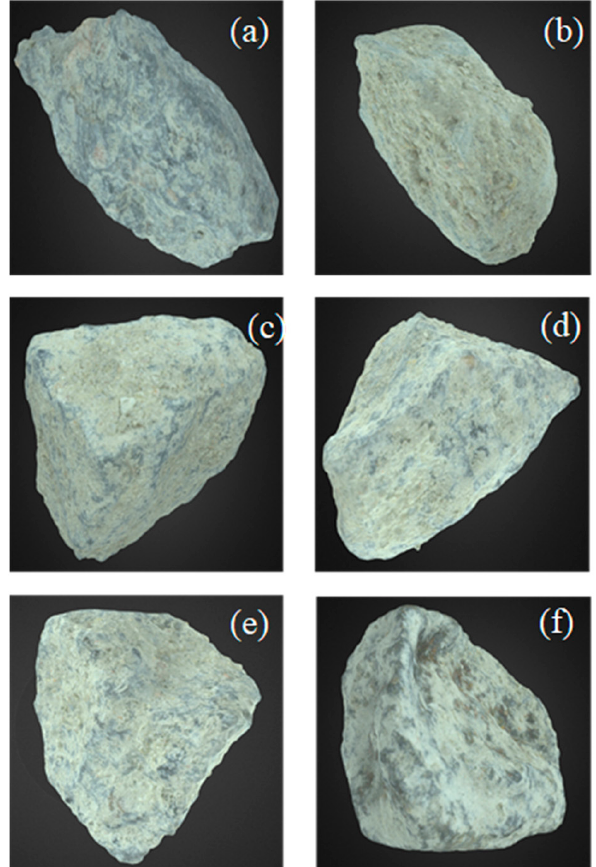
Figure 7. 3D model observation of ( a ) NA, ( b ) RAS0, ( c ) RAS1, ( d ) RAS2, ( e ) RAS3 and ( f ) RAS4